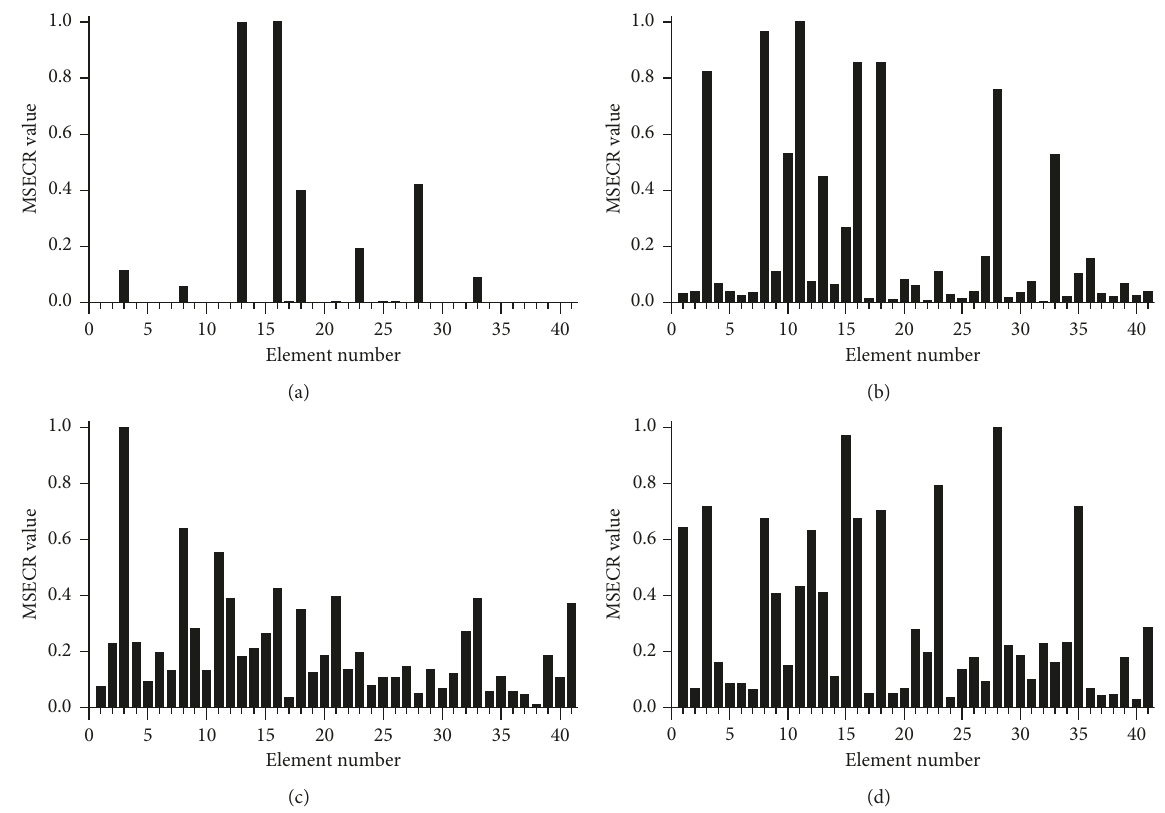
Figure 5: Values of the classic MSECR using the first several modes together (damaged element 9, with 5% noise). (a) Using modes 1-2. (b) Using modes 1–4. (c) Using modes 1–6. (d) Using modes